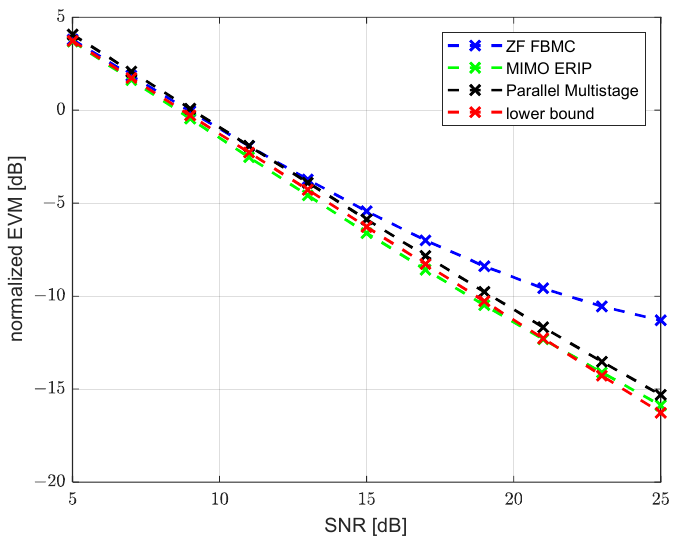
Figure 8. EVM performance versus SNR for HFHQ channel model.